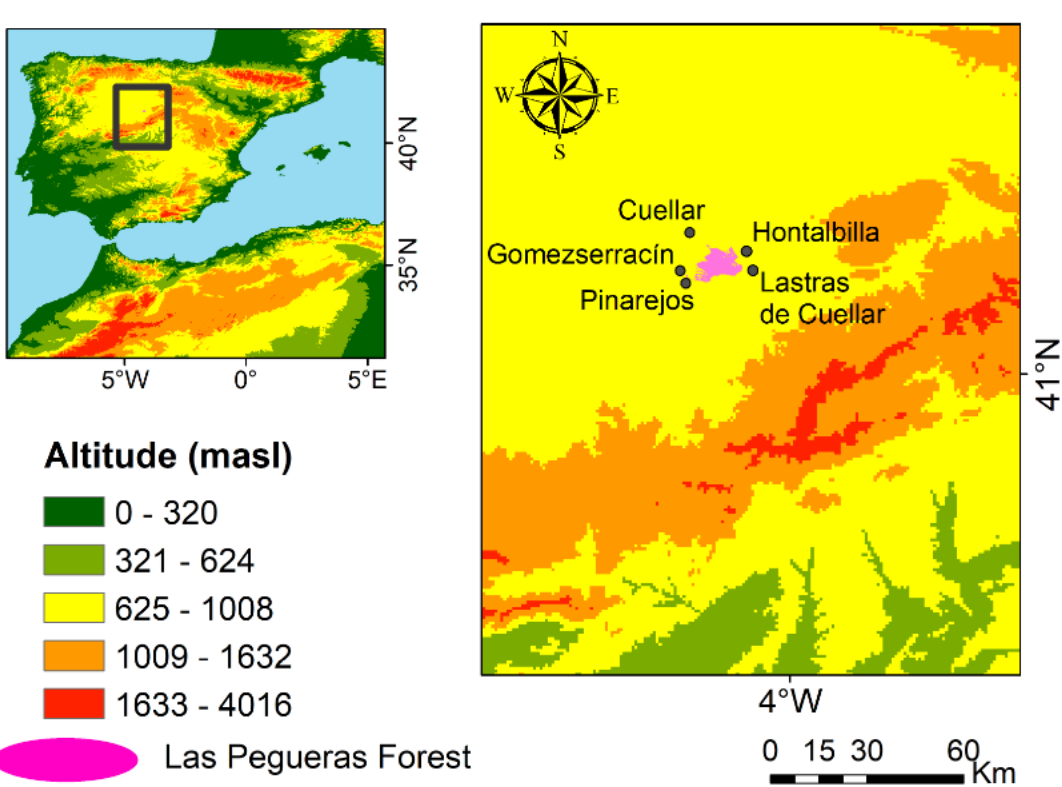
Figure 1. Location of Las Pegueras Forest and the five villages surrounding the forest.